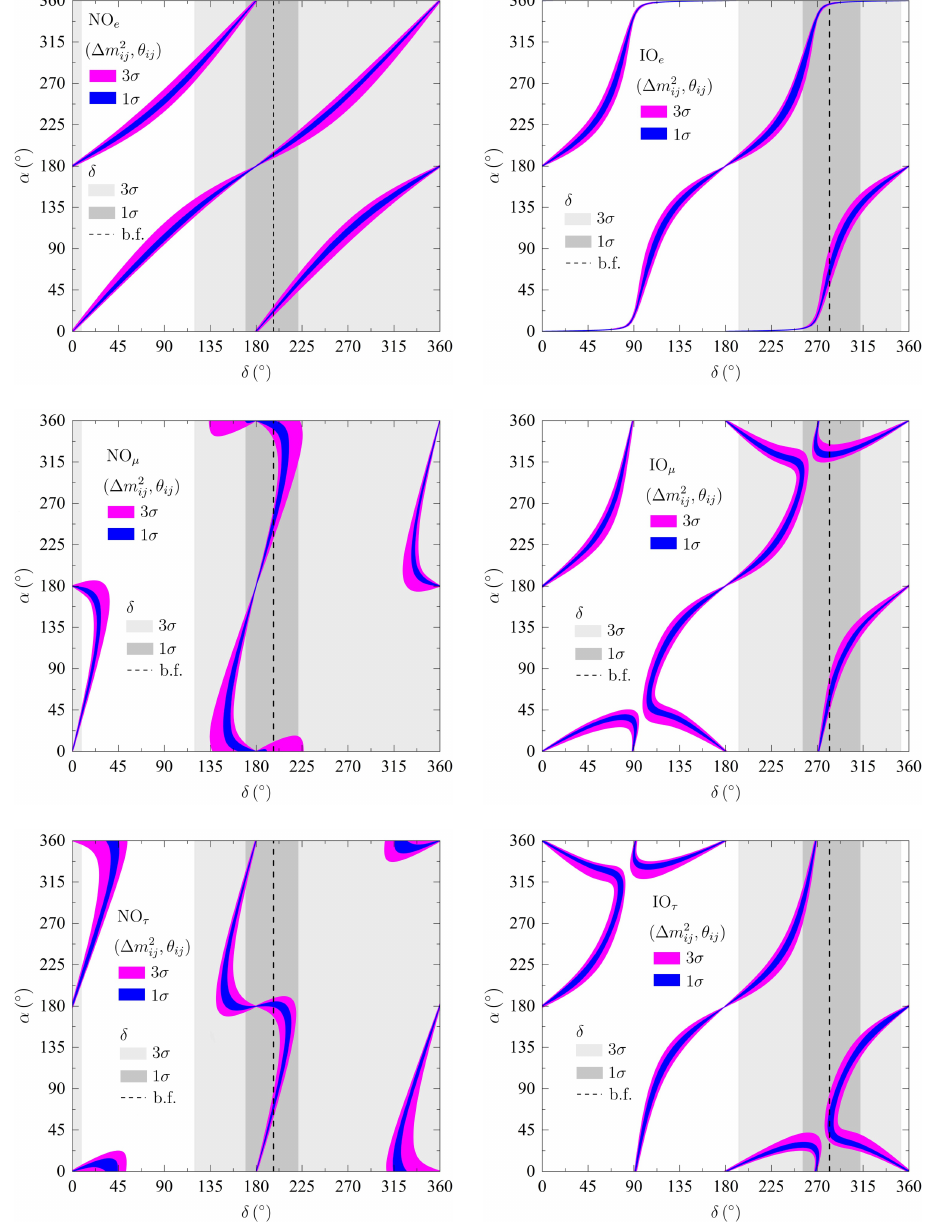
Figure 1 . Predictions for the Majorana phase α as function of the Dirac CP phase δ varying the neutrino mixing angles θ and the neutrino mass-squared differences ∆ m 2 and ∆ m 2 in the 1 σ ij 21 31 (blue) and 3 σ (magenta) allowed ranges given in table 1. The dark (light) grey vertical band marks the 1 σ ( 3 σ ) range for δ shown in the same table, while the vertical dashed line is at the δ best-fit value. The left (right) column corresponds to the cases with NO (IO) neutrino mass spectrum and a charged lepton mass matrix of the 5 e (top), 5 µ (middle) and 5 τ (bottom) type. Hereafter, these 1 1 1 different possibilities will be labelled as NO and IO e,µ,τ e,µ,τ